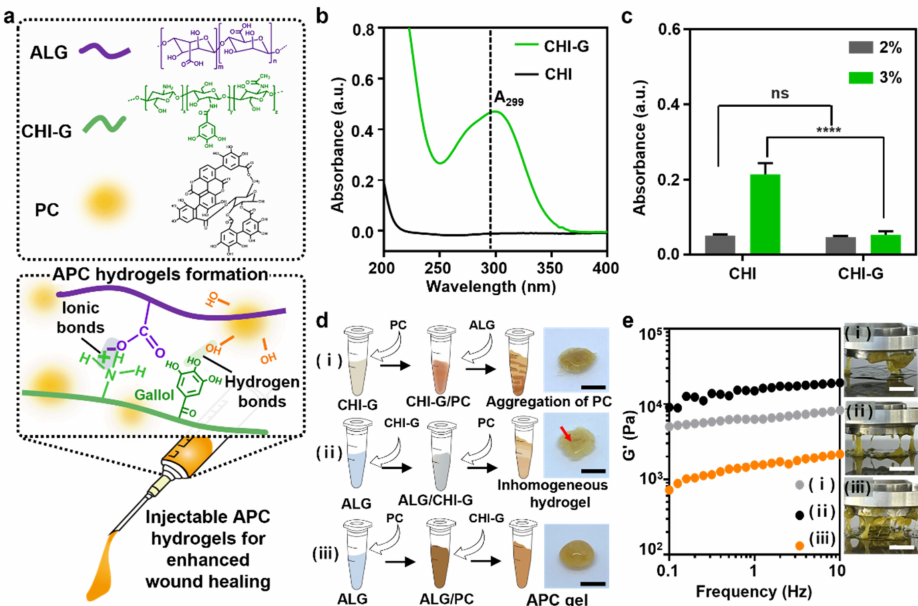
Figure 2. Preparation of APC hydrogels. ( a ) Chemical structure of the main components existed in injectable APC hydrogels ( top ) and their gelation via ionic and hydrogen bonds ( bottom ). ( b ) UV-Vis spectra of CHI (black) and CHI–G (green) ( n = 3). Dashed line (black) indicates 299 nm. Statistical significance and p values are determined by one-way ANOVA followed by Tukey’s post-hoc test. **** p < 0.0001; ns denotes not significant. ( c ) Turbidities of different concentrations of CHI (gray) and CHI–G (green) solubilized in water. ( d ) Schematic of gelation condition for varying mixing sequences of components ALG, PC, and CHI–G. Red arrow indicates aggregation of PC. Scale bar: 10 mm. ( e ) Rheological properties ( left ) and photos ( right ) of different hydrogels for varying sequences. Scale bar: 10